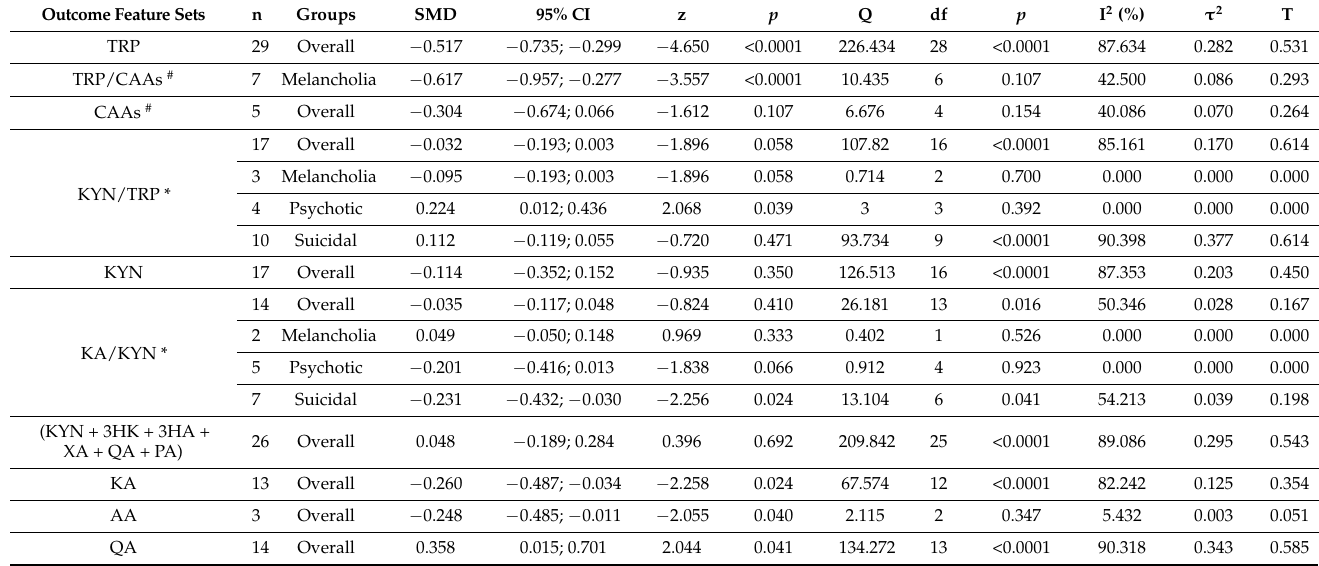
Table 2. Results of meta-analysis performed on several outcome (TRYCATs) variables with combined different media and separately.